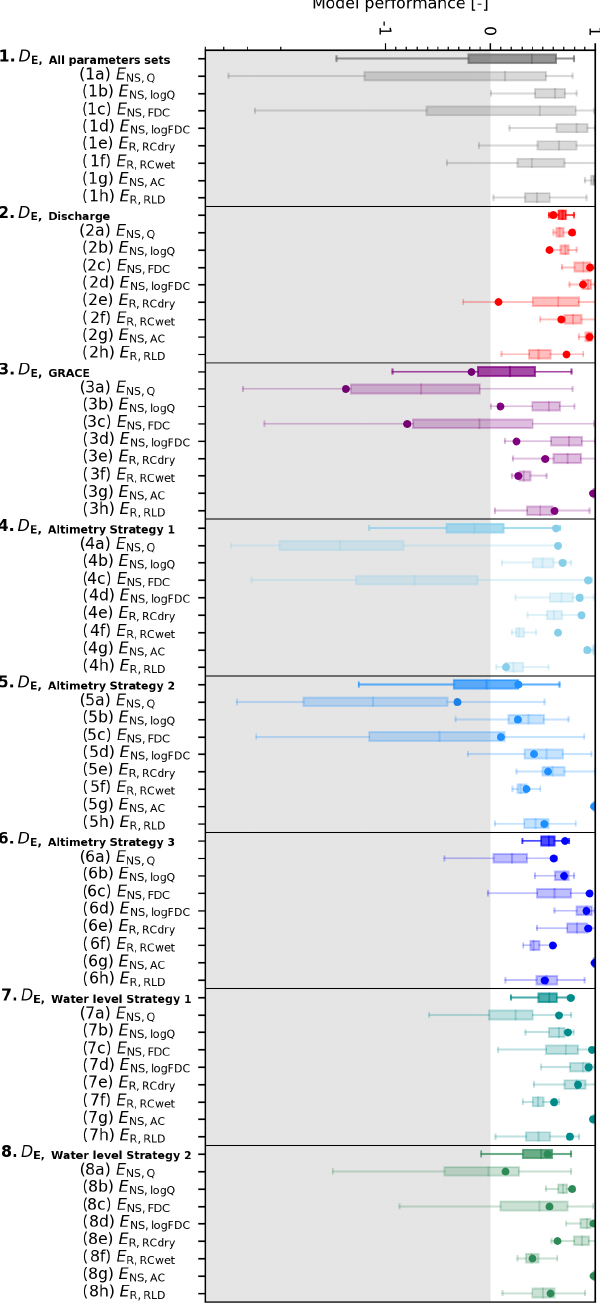
Figure 7. Comparison of different data sources to identify feasible parameter sets. Data sources applied: (1) all random parameters (no data), (2) discharge, (3) GRACE, (4) altimetry data combined with GRACE (Altimetry Strategy 1), (5) altimetry data using the rating curves combined with GRACE (Altimetry Strategy 2), and (6) altimetry data using the Strickler–Manning equation combined with GRACE (Altimetry Strategy 3), and (7) daily river water level combined with GRACE using the Strickler–Manning equation and cross-section information retrieved from Google Earth (Water level Strategy 1) or (8) obtained from a detailed field survey with an ADCP (Water level Strategy 2). The boxplots visualize the spread in the overall model performance D E with respect to discharge and the following individual signatures: (a) daily discharge ( E NS ,Q ), (b) its logarithm ( E NS , log Q ), (c) flow duration curve ( E NS,FDC ), (d) its logarithm ( E NS , logFDC ), (e) average runoff coefficient during the dry season ( E R,RC ), (f) average seasonal runoff coefficient during the wet season ( E R,RC ), dry wet (g) autocorrelation function ( E NS,AC ), and (h) rising limb density ( E R,RLD ). The dots visualize the model performance when selecting the parameter set with the highest model efficiency according to each parameter identification